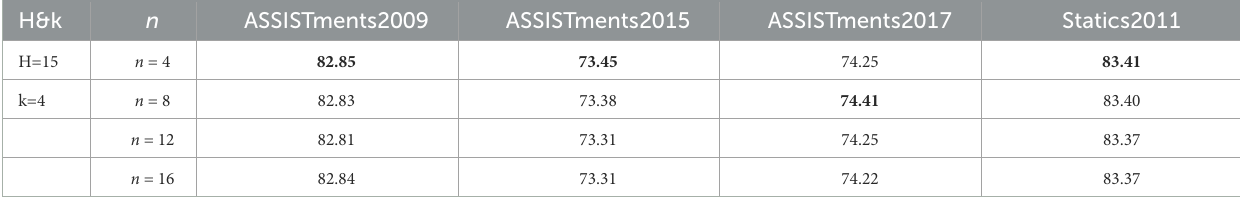
TABLE 7 The AUC results (%) for varying n